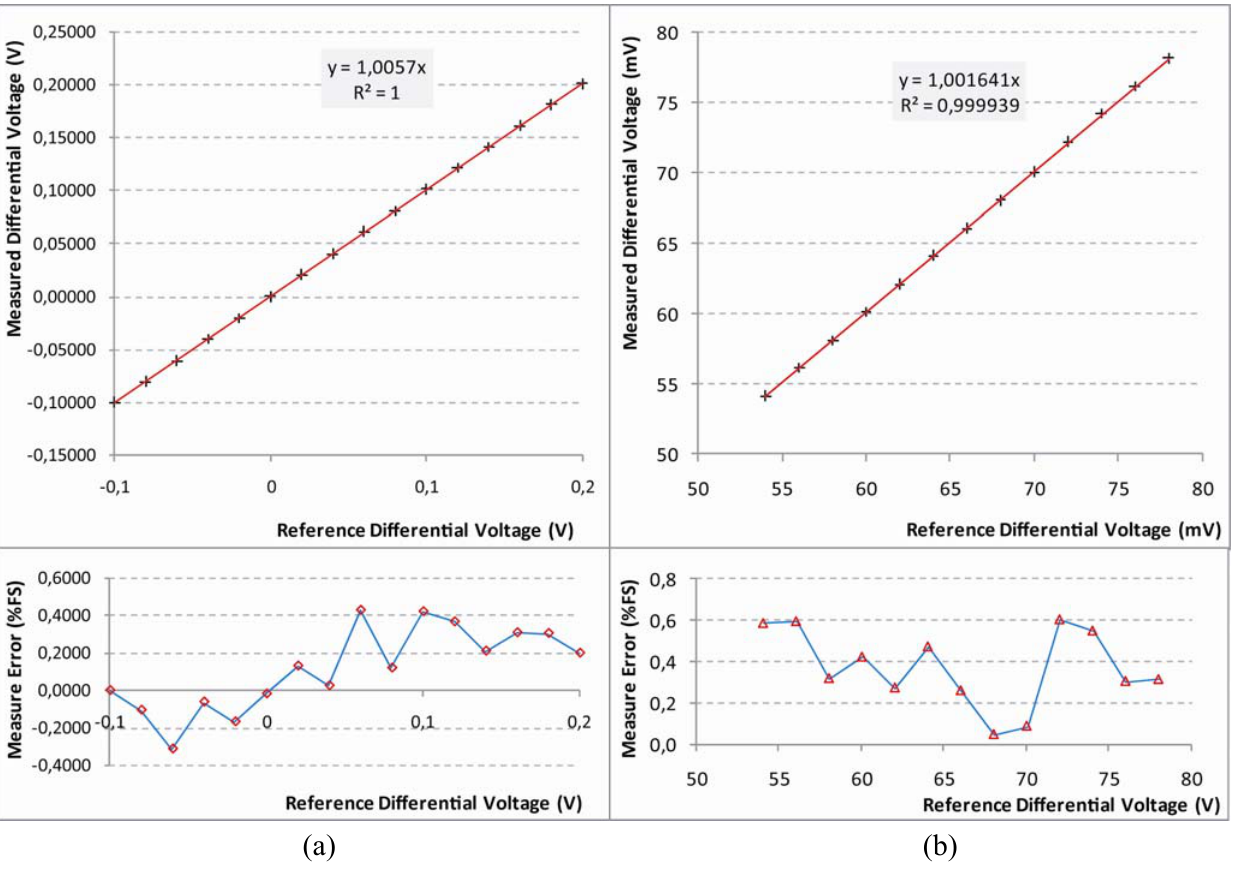
Figure 16. Results of characterization test carried out on UISI Unconditioned Sensor configuration for (a) high differential signal with small offset and (b) small differential signal with high offset. In both figures the top graph shows the measured voltage vs. the reference voltage; bottom graph shows the corresponding error in Full Scale (FS)